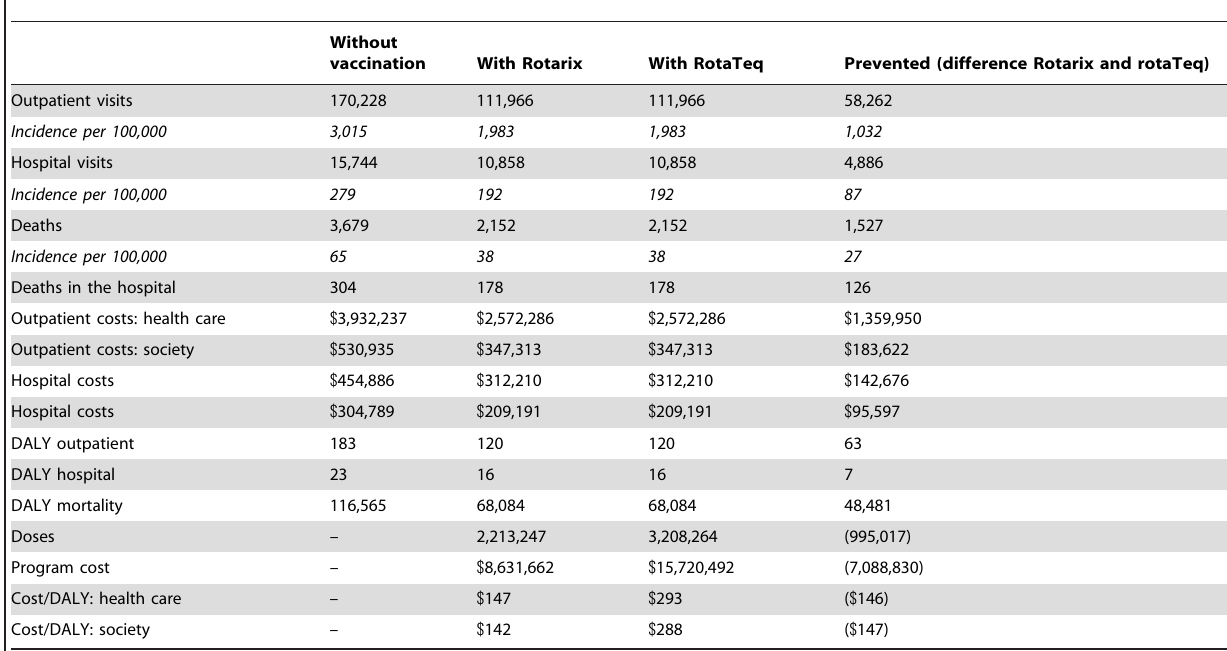
Table 3. Overview of the number of cases, discounted costs and DALYs, programme costs and Cost/DALY for the situation without vaccination and with vaccination and the prevented number of cases and costs.